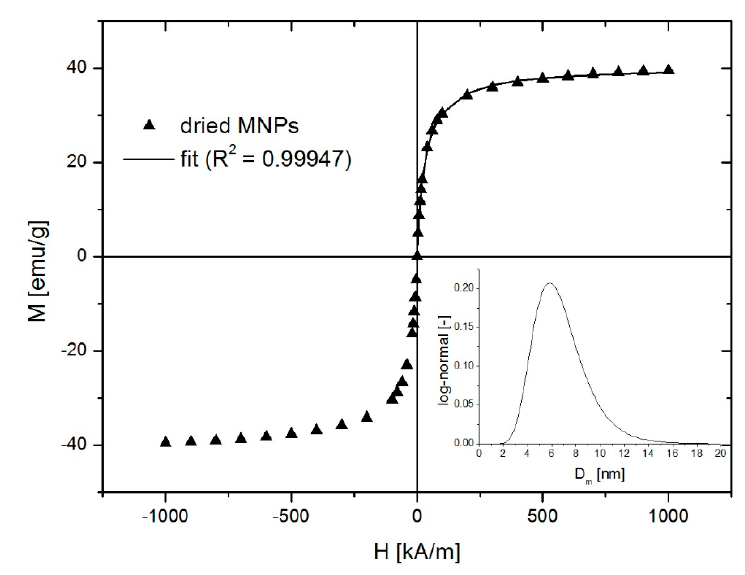
Figure 5. Magnetization plot of dried magnetite nanoparticles.